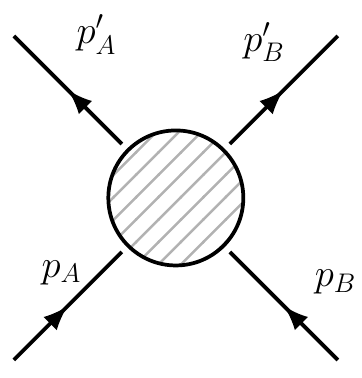
Figure 2 . Kinematics of our 2